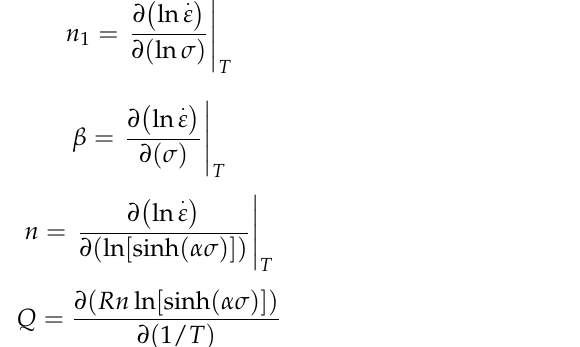
( e ) Figure 5. Relationships between σ , ln σ , ln ε ̇ , 1000/ T , ln [sinh( ασ )] and ln Z : ( a ) σ – ln ε ̇ , ( b ) ln σ – ln ε ̇ , ( c ) ln [sinh( ασ )] – ln ε ̇ , ( d ) ln [sinh( ασ )] − 1000/ T , ( e ) ln Z − ln [sinh( ασ )]. Table 2 lists the material constants ( A , α , n , Q ) obtained at strain 0.15. In a previous study, the average activation energy Q of AISI 4340 was reported as 385.584 kJ/mol [2]. Considering that the flow stress is affected by strain, the material constant values were obtained from 0.05 to 1.0 at intervals of 0.05 for each strain. Table 2. Values of material constants at ε = 0.15. α (MPa −1 )